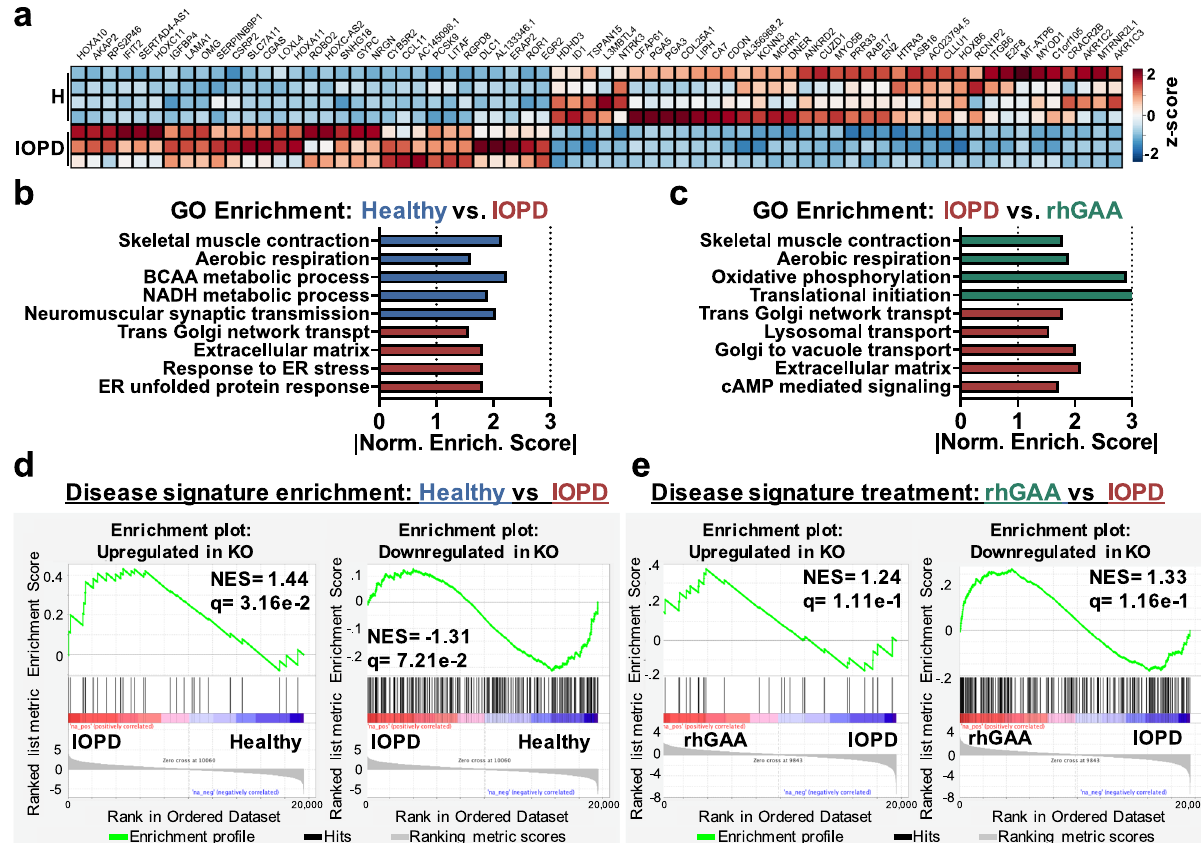
Fig. 5 Transcriptomic changes in myobundles as a result of IOPD and rhGAA treatment. a , RNA-seq heatmap of genes with signi fi cantly different (p adj < .05, |log 2 FC| ≥ 1) expression in IOPD vs. healthy myobundles. b GSEA on RNA-seq data to identify GO terms enriched in healthy (blue) or IOPD (red) myobundles plotted against normalized enrichment score (NES) (FDR < 0.15). c GSEA on RNA-seq data to identify GO terms enriched in rhGAA- treated (green) or untreated (red) IOPD myobundles (FDR < 0.15). d Enrichment plots of myobundles (IOPD vs. healthy) using disease signature gene sets consisting of the top 50% of the most signi fi cantly altered genes ( p adj < 0.05, |log 2 FC| ≥ 2 in KO vs. WT RNA-seq), 39 of which were upregulated (left) and 243 downregulated (right) in KO vs. WT mice. e Enrichment plots of Pompe disease reversal in rhGAA-treated vs. untreated IOPD